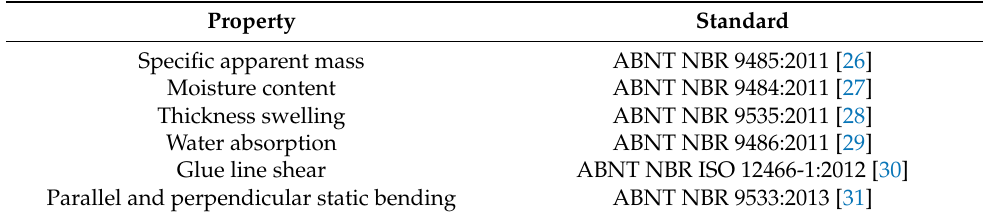
Table 2. Physical and mechanical evaluations.